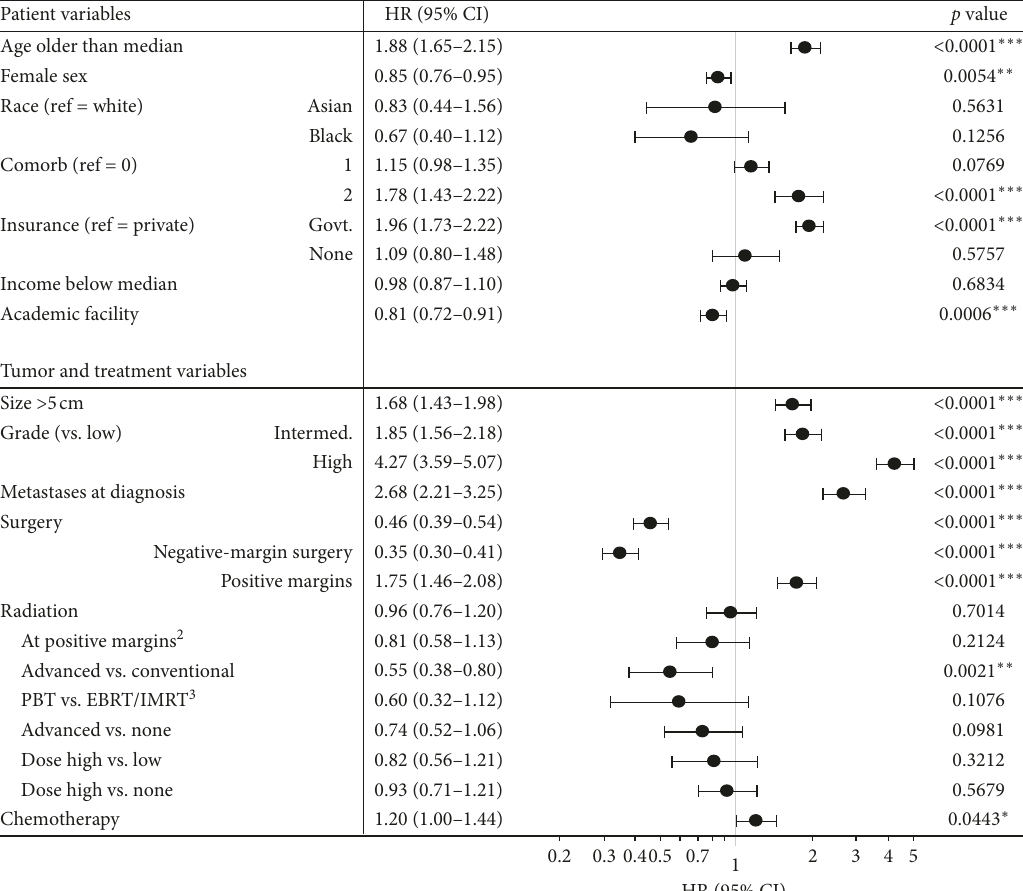
Figure 4: Multivariate Cox proportional hazards regression for independent predictors of mortality in patients with chondrosarcoma. Forest plot of hazard ratios and 95% confidence intervals displayed for patient, tumor, and treatment variables. Base model performed with radiation type variable categorized by both radiation modality and dose. 2 Model repeated to assess the impact of margin status on the survival effect of radiation therapy. 3 Radiation modalities of EBRT and IMRT were combined and compared with